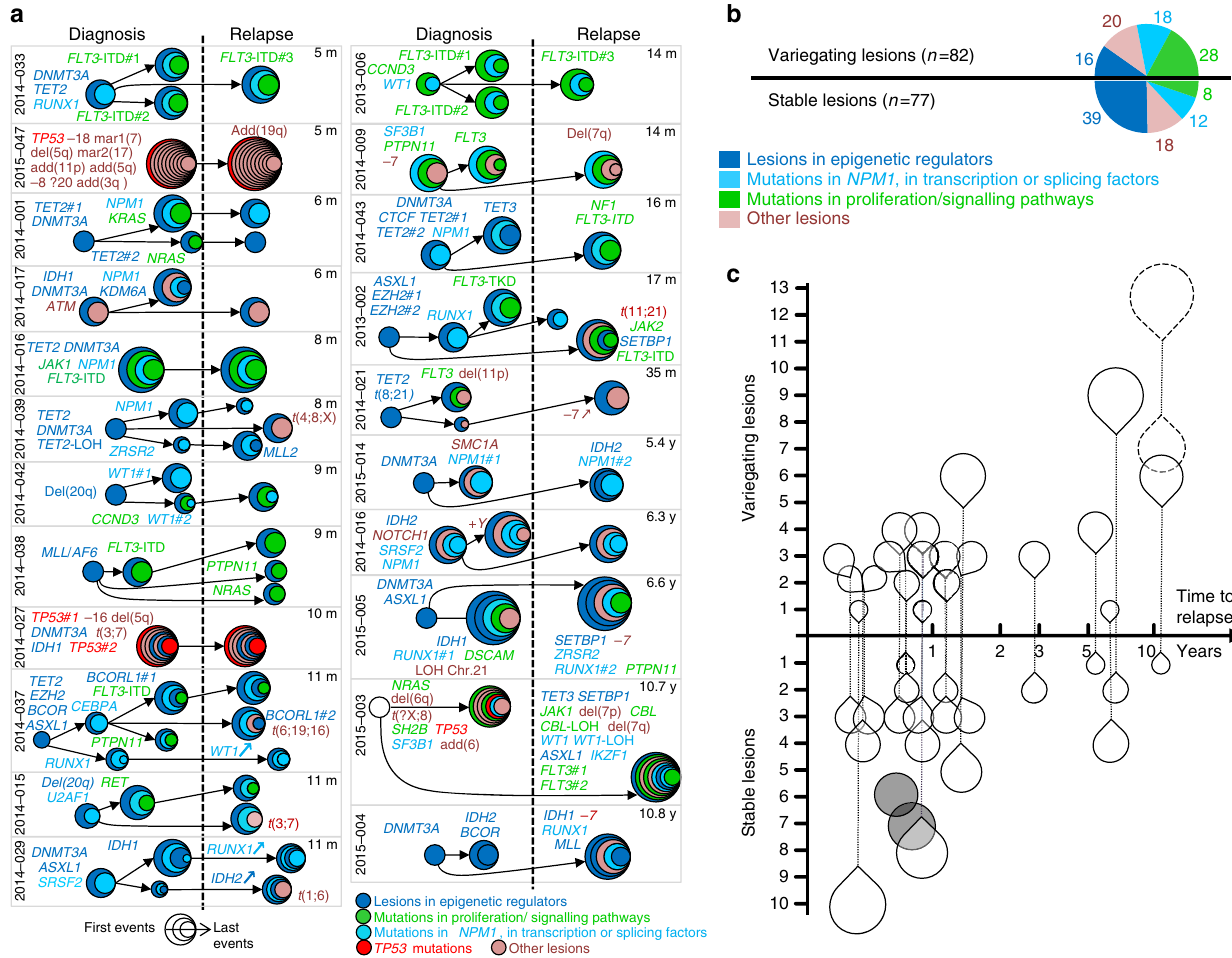
Figure 2 | Temporal variegation govern AML relapse. ( a ) Clonal composition of 22 AMLs at diagnosis and relapse. Internally tangent circles represent successive lesions. Arrows indicate subclonal evolution inferred as indicated in the material and methods section. Delay from diagnosis to relapse is indicated in the upper right corner of each panel (m, months; y, years). ( b ) Numbers of stable and variegating lesions between diagnosis and relapse samples in the 22 AMLs. Colours are as in ( a ) with TP53 mutations included in the group of ‘other lesions’. ( c ) Changes in clonal composition as a function of time to relapse. Droplets above and below the x axis represent the number of variegating and stable lesions, respectively. Paired droplets of single patients are connected by vertical lines. Droplets outlined by dashed lines indicate lesions from one patient whose relapse lesions (top droplet) were all different from diagnostic ones (bottom droplet). Grey circles indicate cases with no changes in clonal